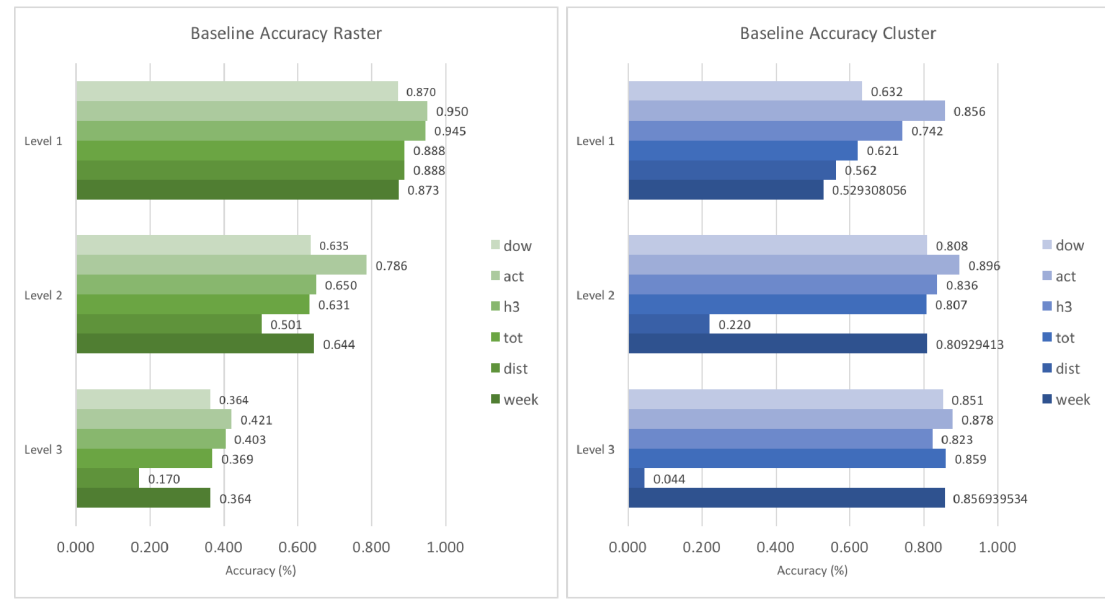
Figure 4. The prediction accuracy of the baseline features broken down by level. While a clear decrease in the raster case is visible, this is only the case for the distance baseline in the clustered